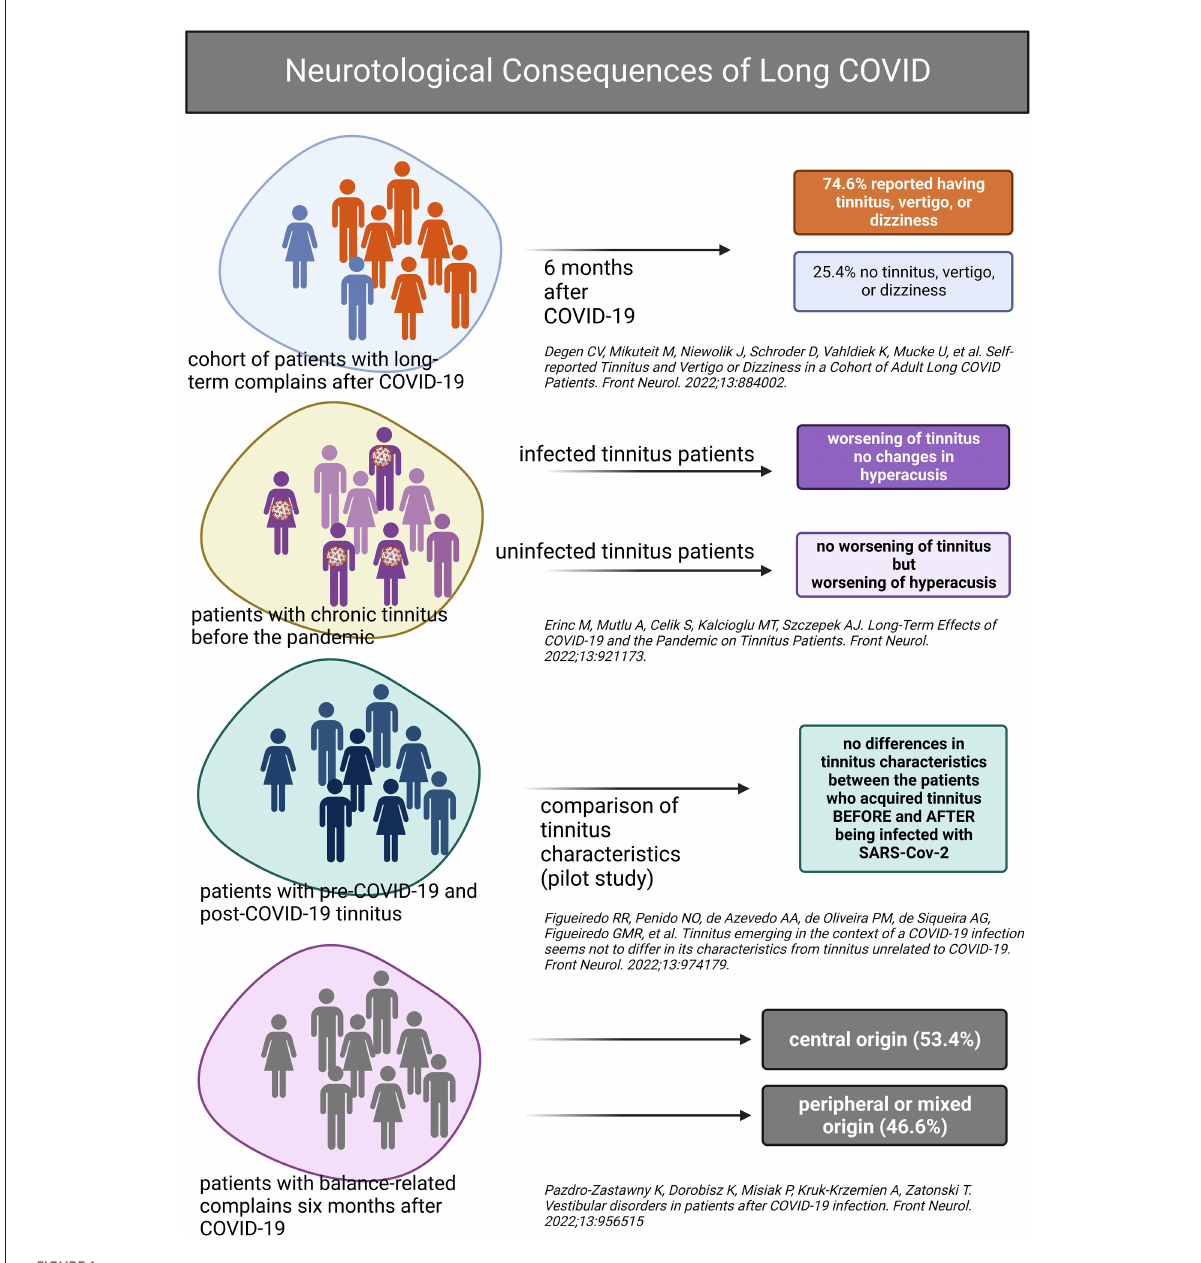
FIGURE1 Graphical summary of the main findings presented in the Research Topic “ Neurotological consequences of long COVID .” Created with BioRender.com.